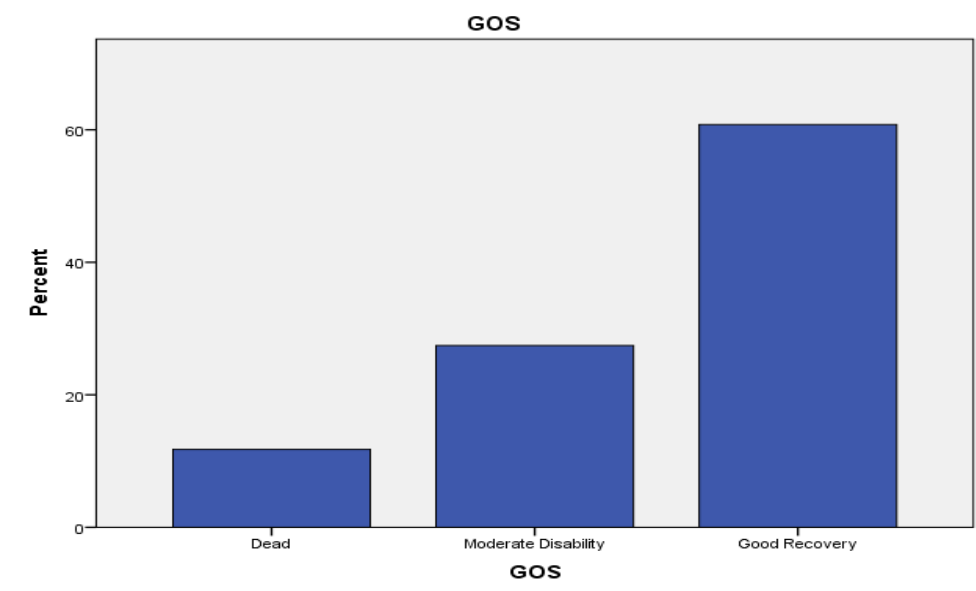
Figure 2: Surgical Outcomes at 6-weeks